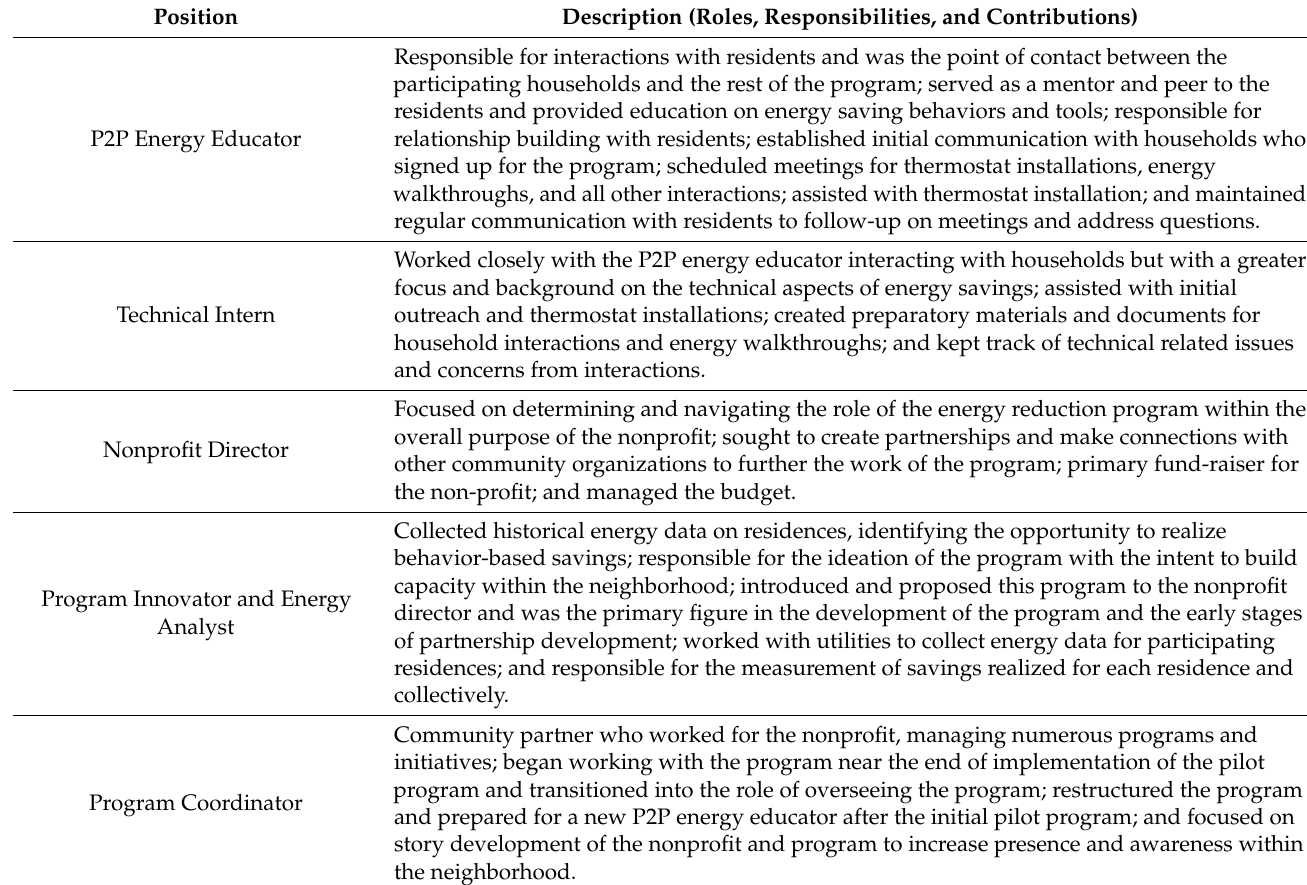
Table 2. Descriptions of Interviewees’